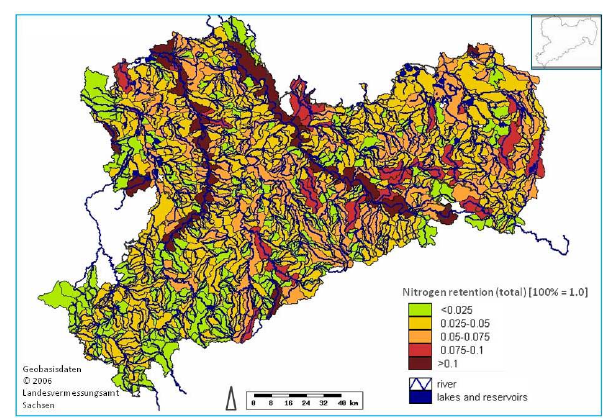
Table 2. Nitrogen inputs into surface water and loadings at selected river basin outlets in Saxony (reference year 2005).